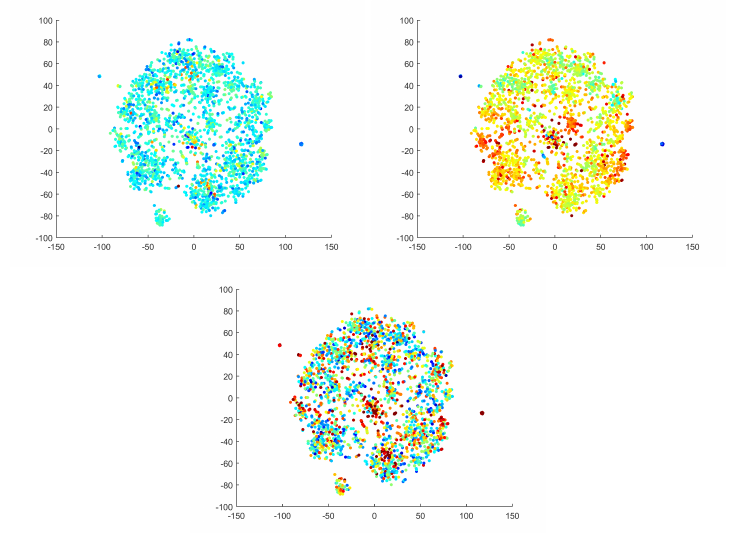
Figure 14. Commonly used EEG criteria displayed in IC space. The autocorrelation criterion on a logarithmic scale ( top left ); the focal criterion on a logarithmic scale ( top right ); the focal trial criterion on a non-logarithmic scale ( below ). The dimensions are formed by topomaps and are